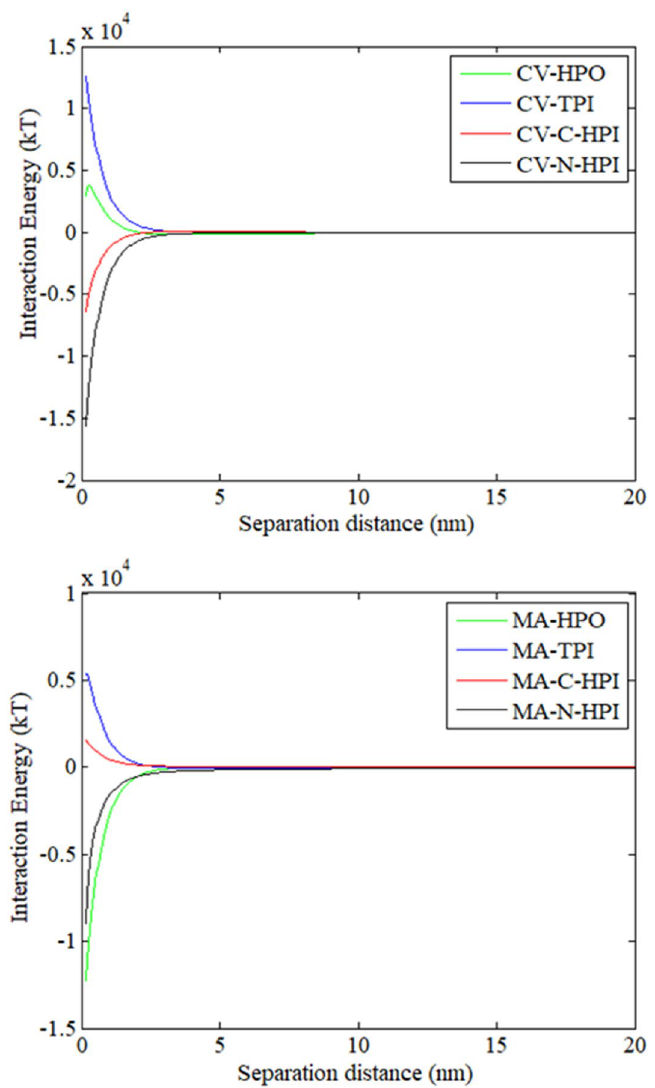
Figure 10. Interaction energy profiles between the fouled membrane surface membrane and CV-IOM and MA-IOM